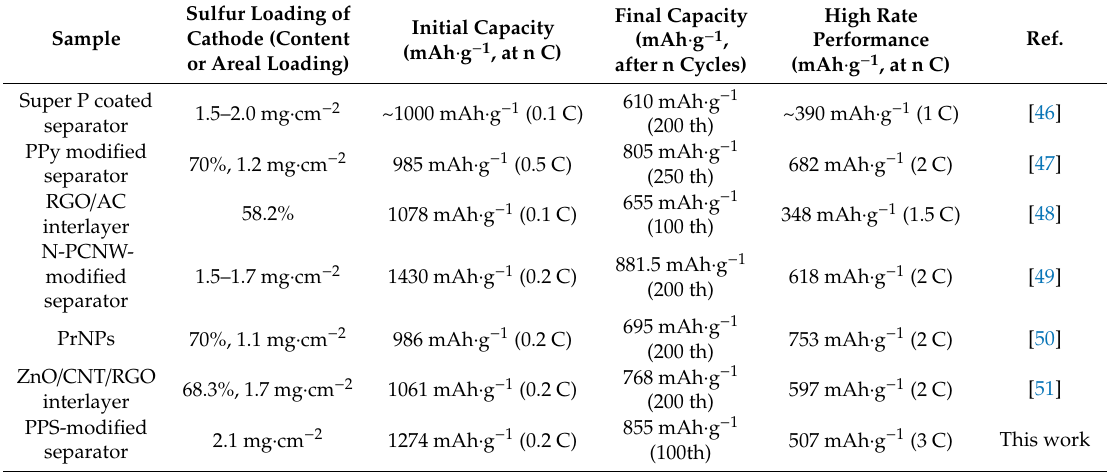
Table 1. Comparison of the electrochemical performance of previous reports with our work.